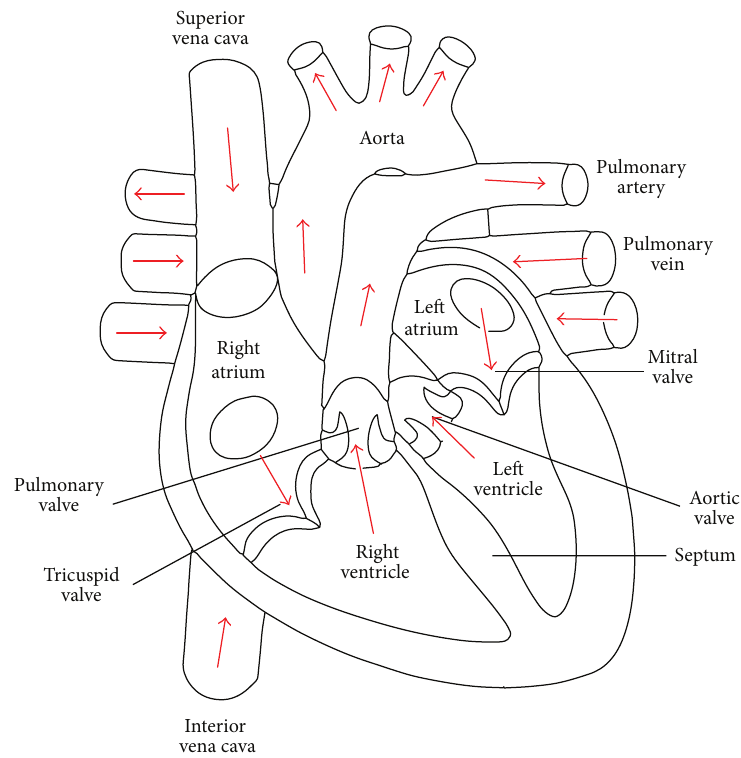
Figure 1: Transverse section of human heart